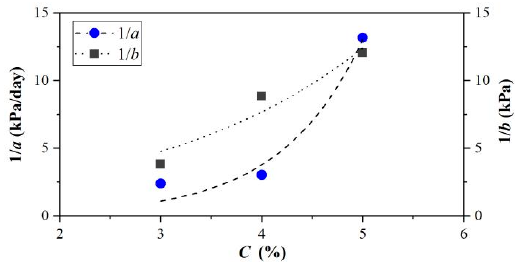
Figure 7. RRelationship between 1/ a , 1/ b, and concentration.